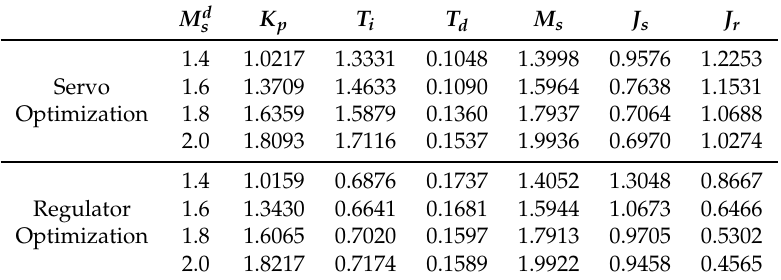
Table 4. Proportional-integral-derivative parameter, M s , and index